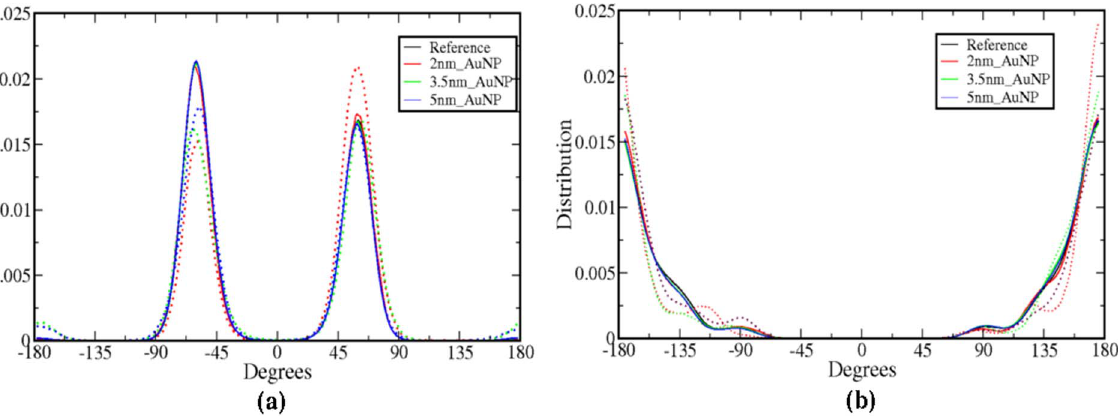
Figure 5. Dihedral angle distribution of the head-group atoms (a) N-C25-C24-O6 (b) C25-C24-O6-P. Dotted and solid lines are for SR and LR lipid molecules